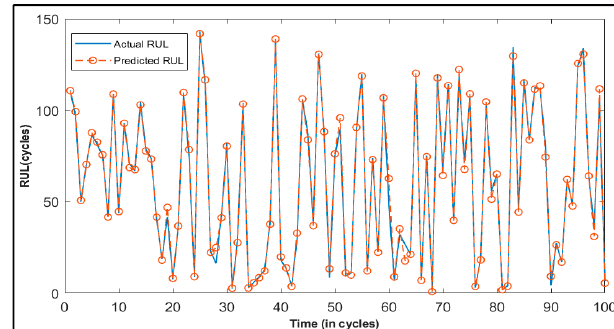
Figure 9. RUL of 100 test